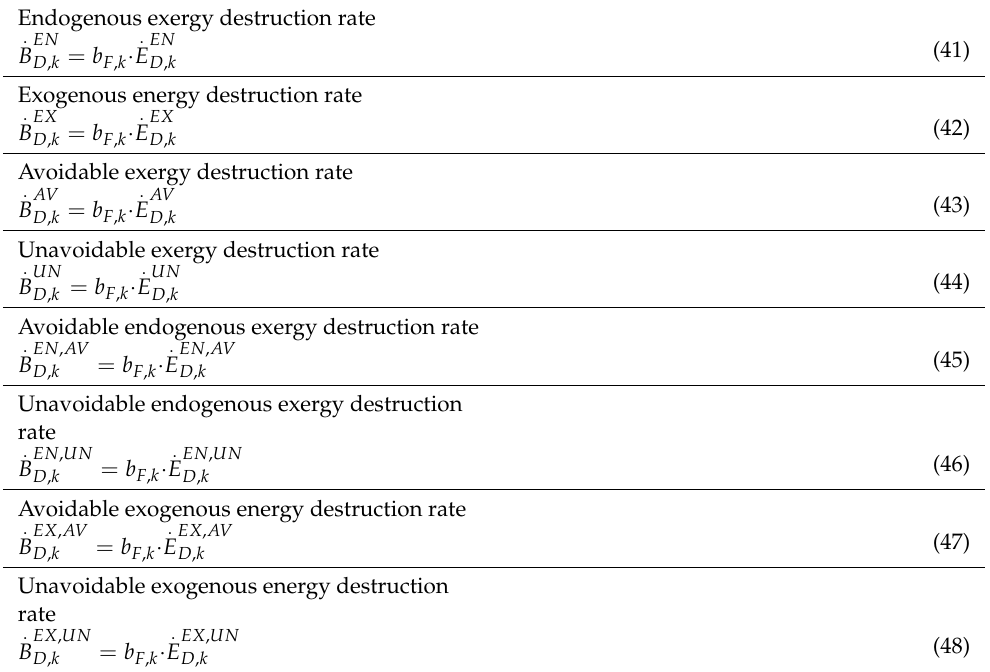
Table 5. Equations related to advanced exergo-environmental analysis. Endogenous exergy destruction rate